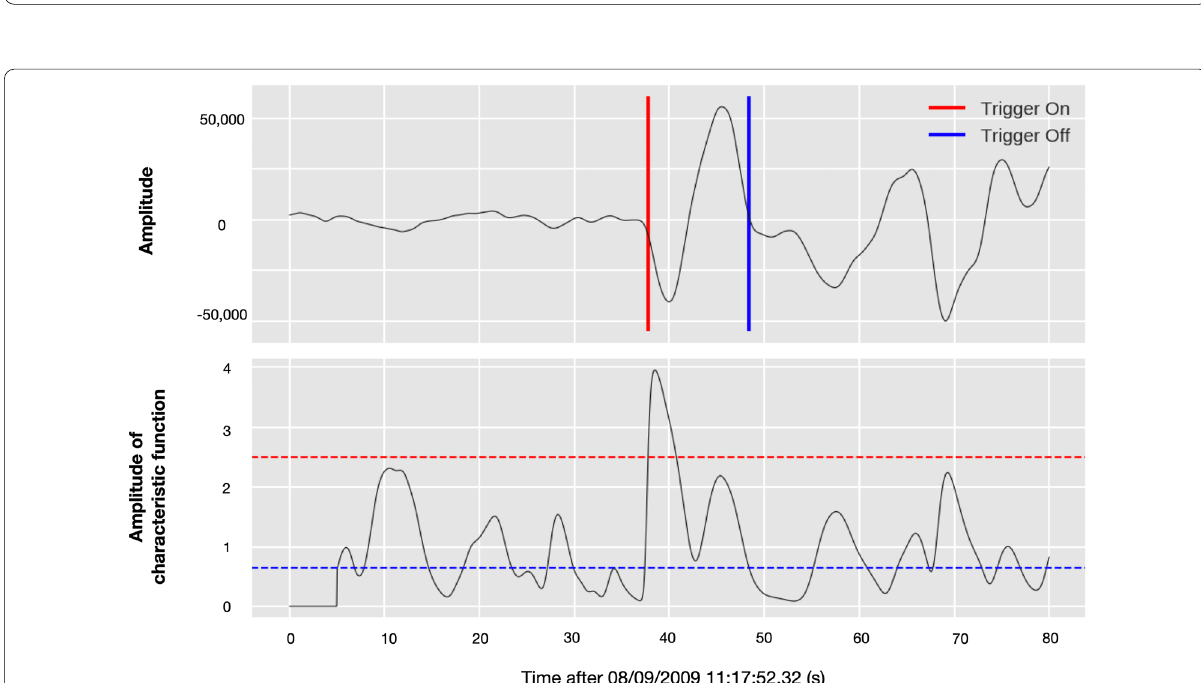
Fig. 8 Automatic selection of the SKS phase using the recursive STA LTA method for the trace depicted in Fig. 7. The red and blue bars indicate the beginning and ending times of the SKS phase, based on values of the characteristic function